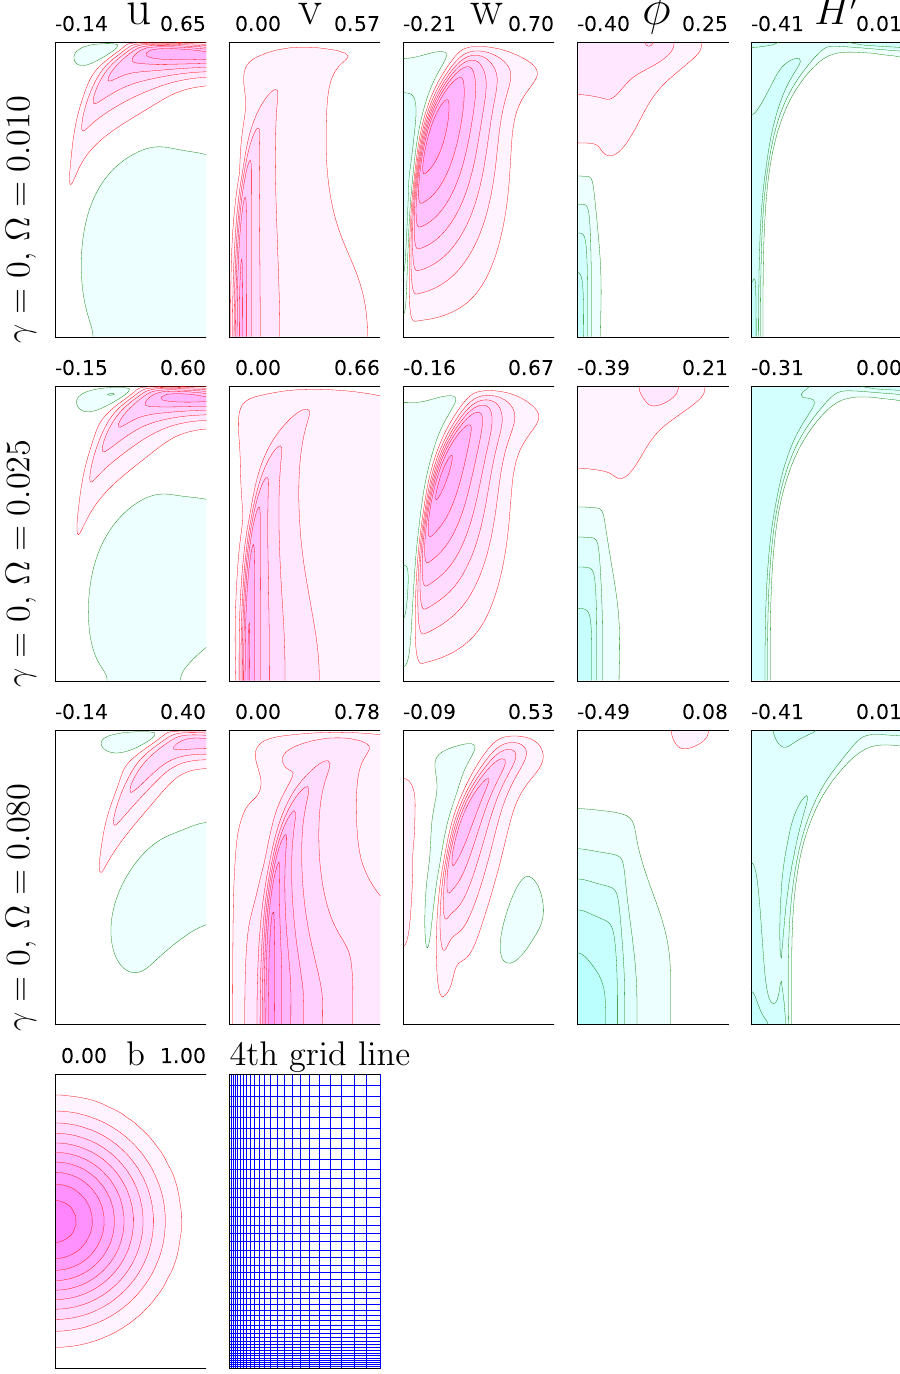
Figure 1. The free-slip simulations at t = 225. Only r < 0.5 is shown. The solutions are steady at this time. The steady buoyancy b ( r , z ) and the 4th grid line of the 181 simulations. The extreme values in the plot ( r < 0.5) are